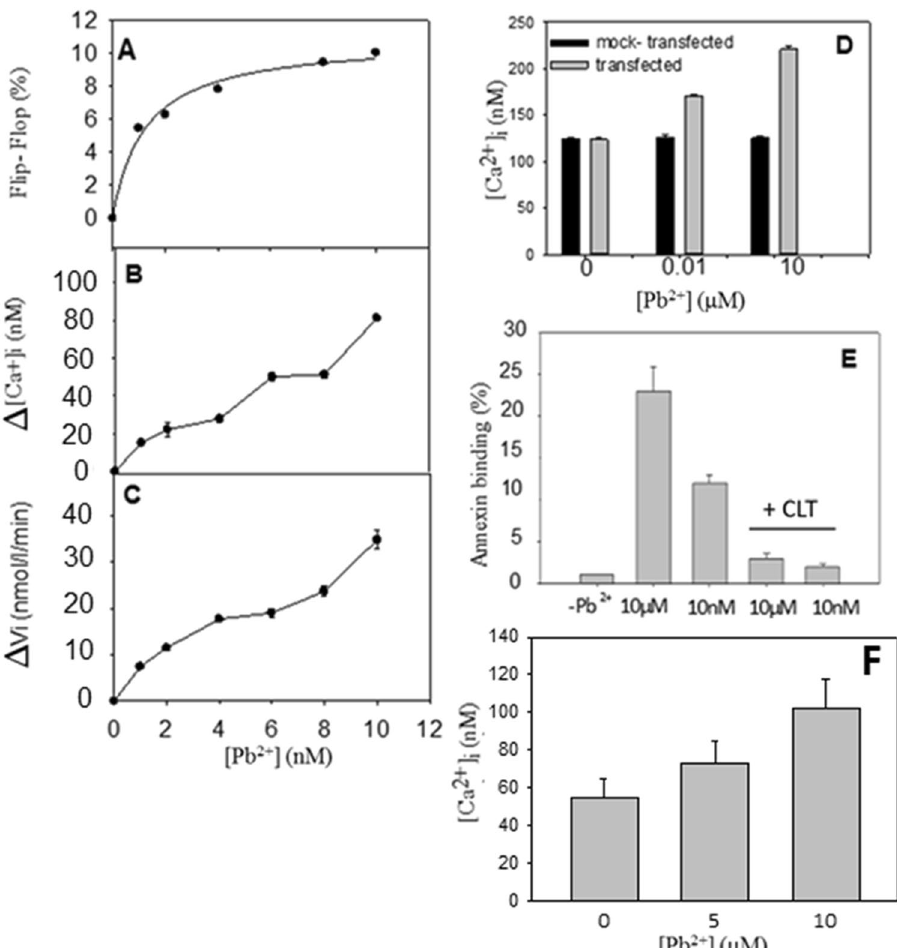
Figure 1. Effect of Pb 2 + ions on cells. ( A ) Outward movement of fluorescent lipid analogue C6-NBD-PS in human RBC as a function of Pb 2 + concentration. ( B ) Pb 2 + - induced increase in intracellular Ca 2 + concentration in human RBC and ( C ) Pb 2 + -induced Ca 2 + entrance rate in human RBC. ( D ) Pb 2 + -induced increase in intracellular Ca 2 + concentration of CHO cells. Intracellular free calcium was measured with Fura-2AM. Gray columns, scramblase-transfected cells; solid black columns, mock-transfected cells. ( E ) Flow cytometric analysis of CHO cell staining with annexin V-FITC, the inhibition of Pb 2 + -induced phosphatidylserine exposure by channel inhibitor clotrimazole (CLT) can be quantified. ( F ) Pb 2 + -induced increase in intracellular Ca 2 + concentration of RBC cells for higher Pb 2 + concentrations than in B. Intracellular free calcium was measured with Fura-2AM. Cells were incubated with Pb 2 + for 1 h prior to measurements. Intracellular free calcium was measured with Fura-2AM. Mean values of three experiments ±